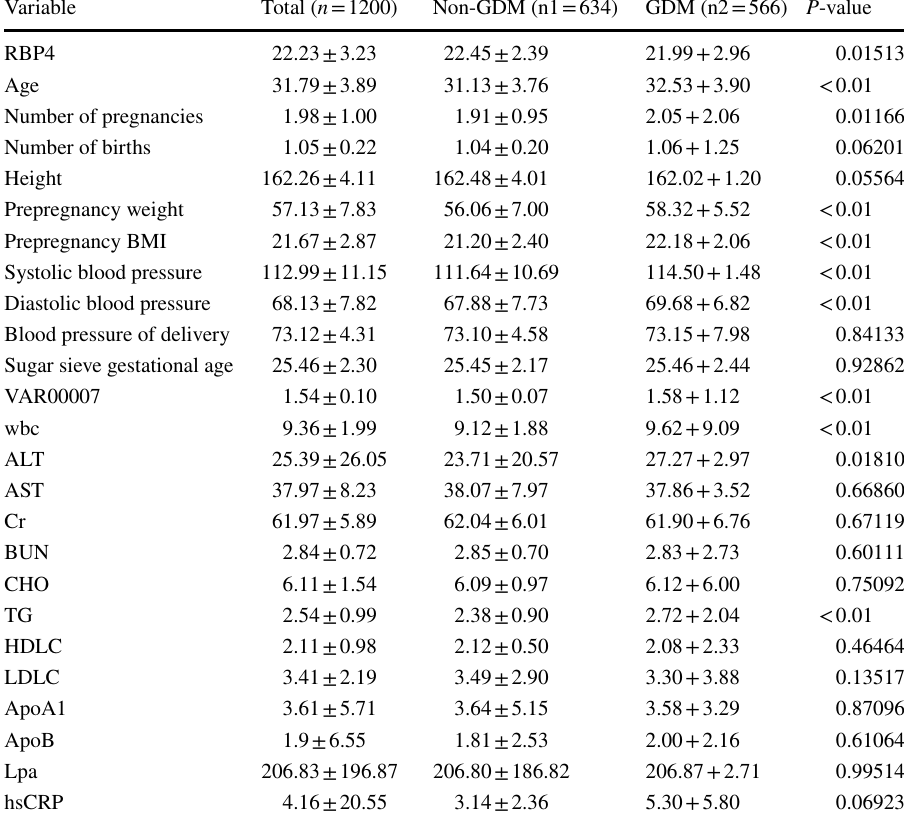
Table 1 General characteristics of the regular variables